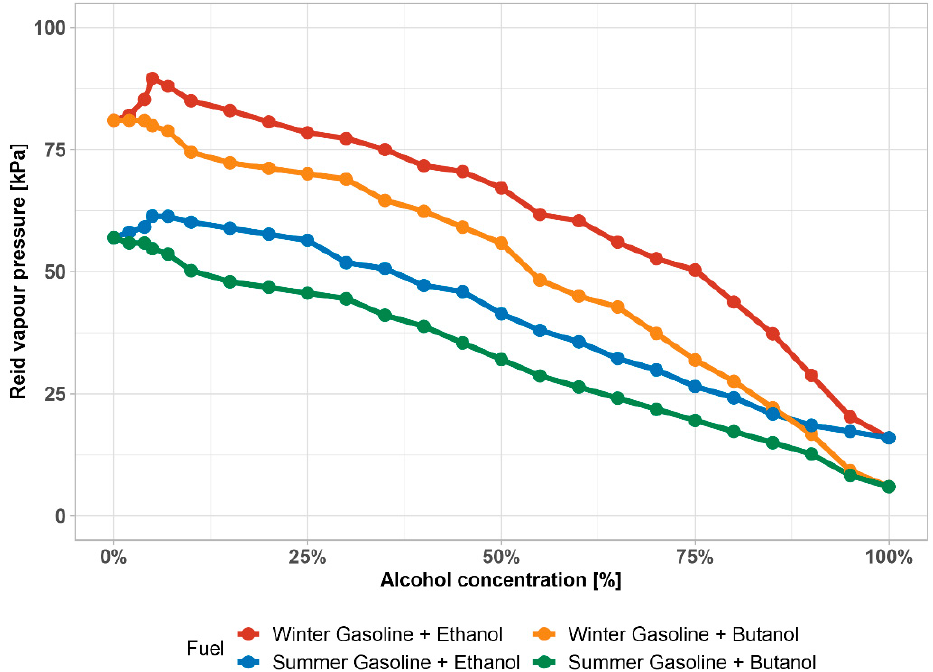
Figure 5. Reid vapor pressure of winter and summer gasoline mixtures, depending on the volume of alcohol added.